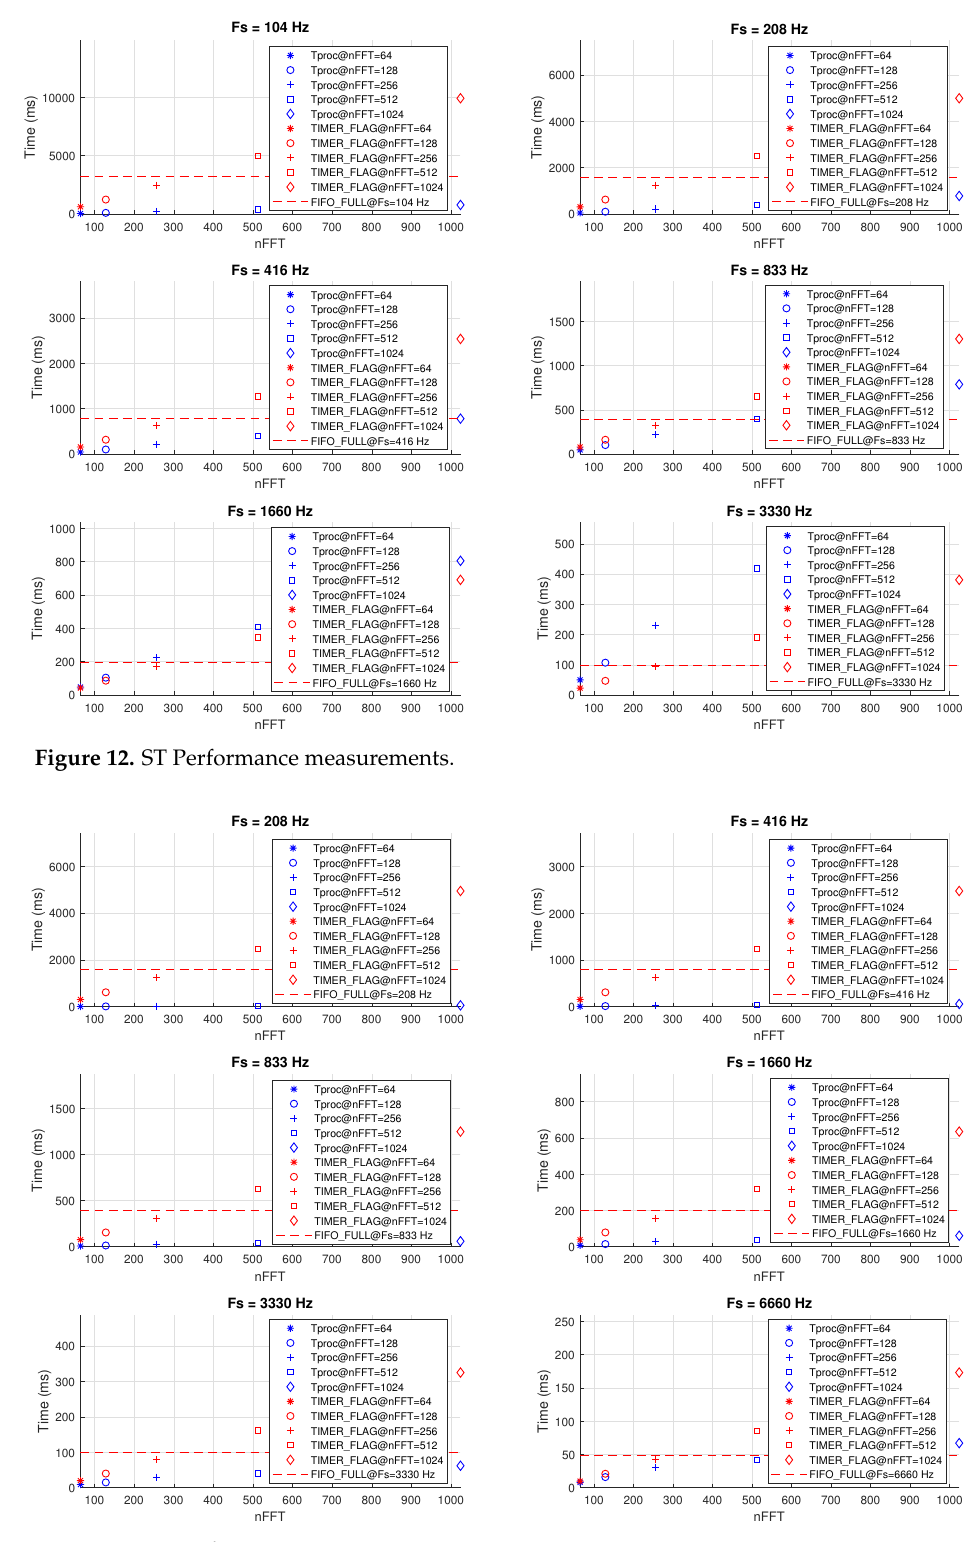
Figure 13. RT Performance